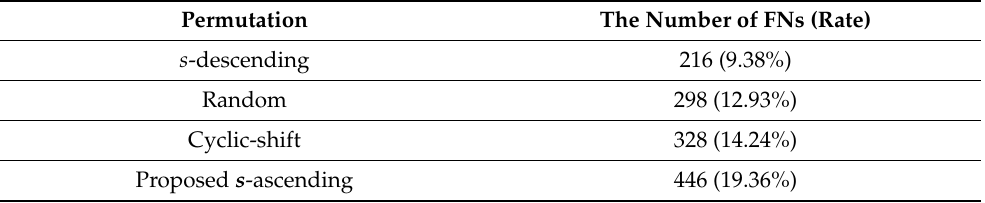
Table 2. The comparison of FNs’ number among different permutations of factor